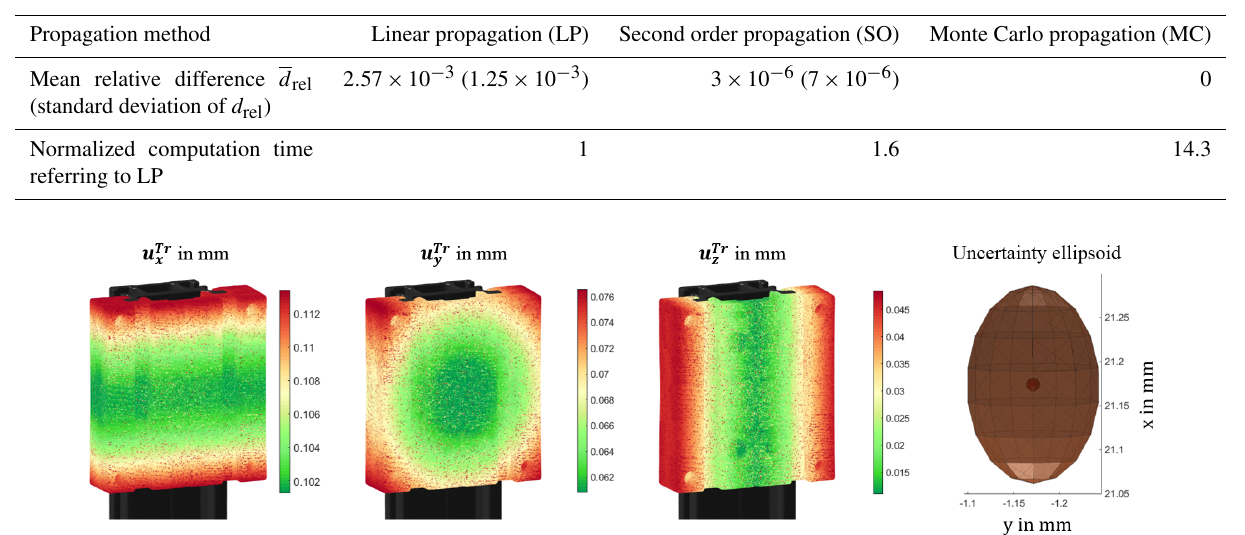
alignment, rotations smaller than 0 . 01rad ( ≈ 0 . 6 ◦ ) are deter- mined by VA, resulting in relative errors of 1 . 7 × 10 − 5 for the sine function and 5 × 10 − 5 for the cosine function. To